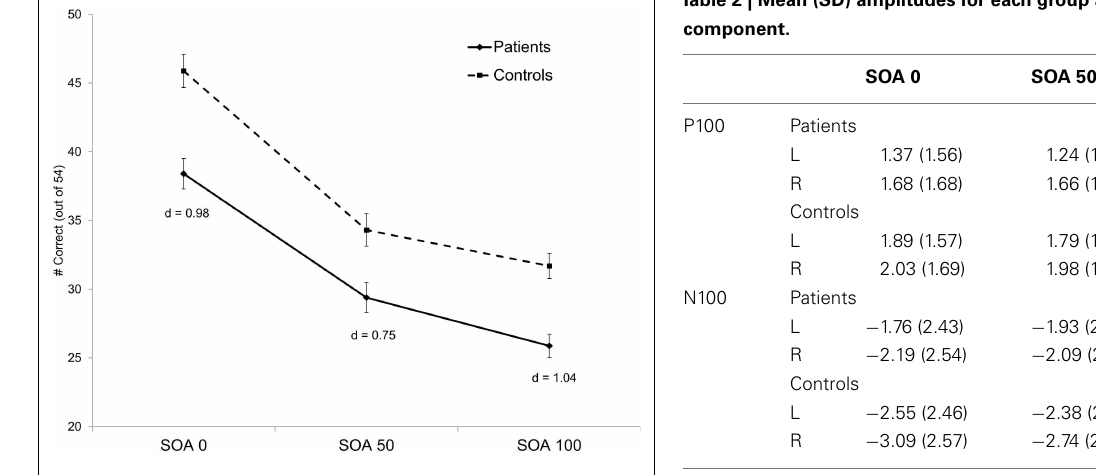
FIGURE 2 | Behavioral performance for each group on the four-dot backward masking task. Groups differed significantly across all SOAs. Bars represent ± one standard error. Cohen’s d effect sizes for between-group differences are presented at each SOA. EEG Means and SD for the two ERP components can be seen in Table 2 .